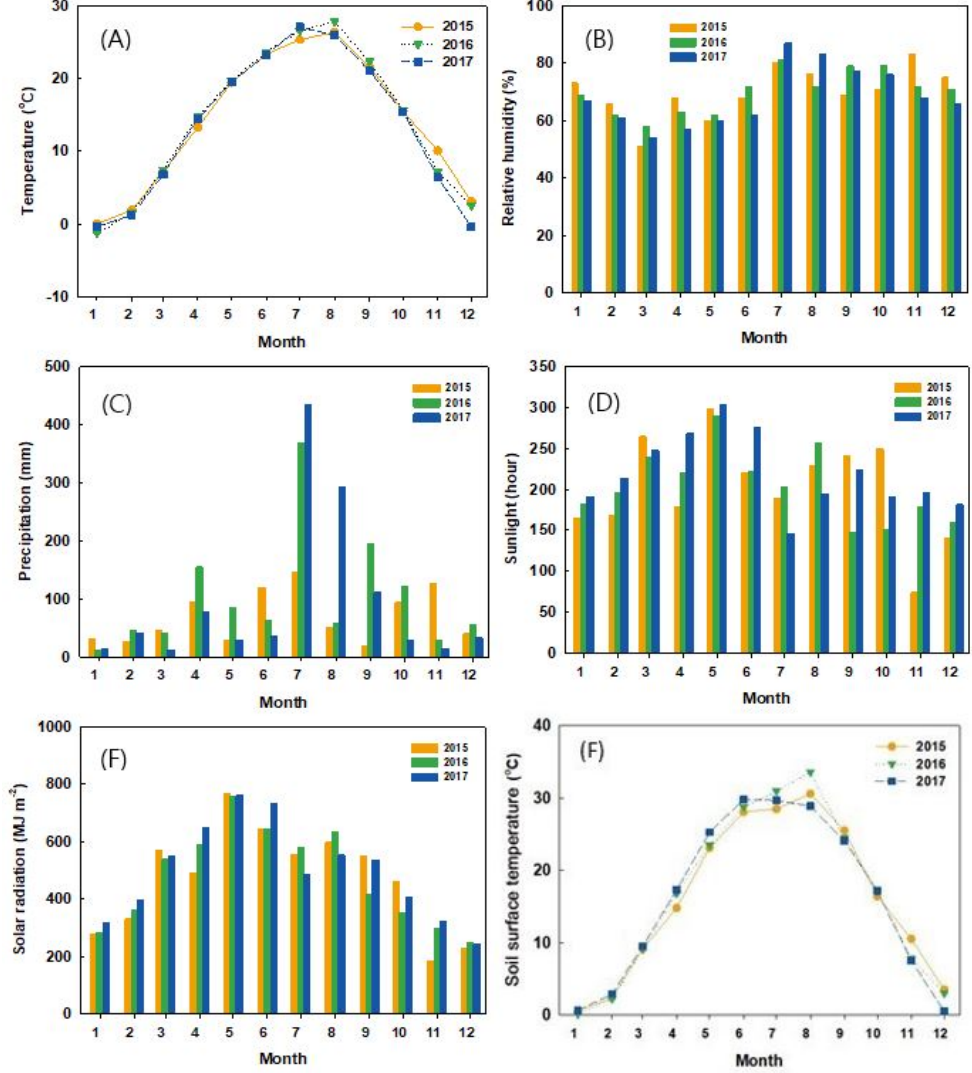
Figure 6. Environmental variables (( A ) monthly average air temperature, ( B ) monthly average relative humidity, ( C ) monthly precipitation, ( D ) monthly sunlight, ( E ) monthly solar radiation, ( F ) monthly average soil-surface temperature) measured close to the study sites. All variables were measured at the Daejeon Meteorological weather station (36 ◦ 22 (cid:48) 19.2 (cid:48)(cid:48) N 127 ◦ 22 (cid:48) 19.6 (cid:48)(cid:48) E) from 2015 to